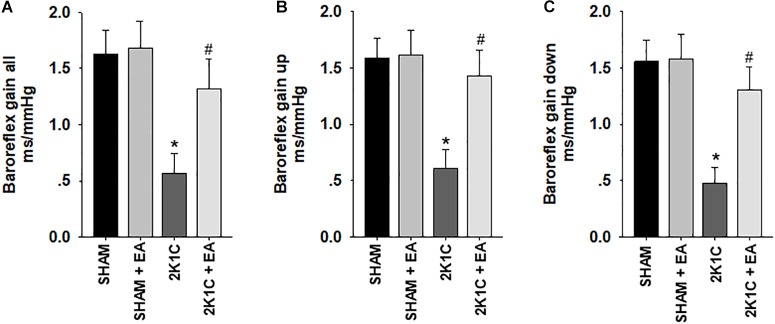
Electroacupuncture (EA) treatment restores the baroreflex response in 2K1C hypertensive rats. Spontaneous baroreflex analysis with overall baroreflex gain (combination of up and down sequences) (A), up sequence gain (B), and down sequence gain (C) (in ms/mmHg). Data are presented as mean ± SE; n = 7 rats; ∗P < 0.01 vs. the sham group; #P < 0.05 vs. the 2K1C group.